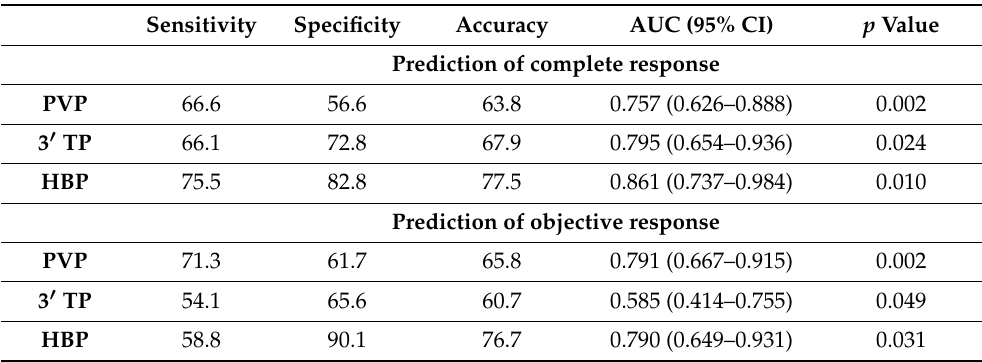
Table 5. Performance of Discriminant Analysis (radiomics model 2) based on the selected features for predicting complete response and objective response (complete and partial